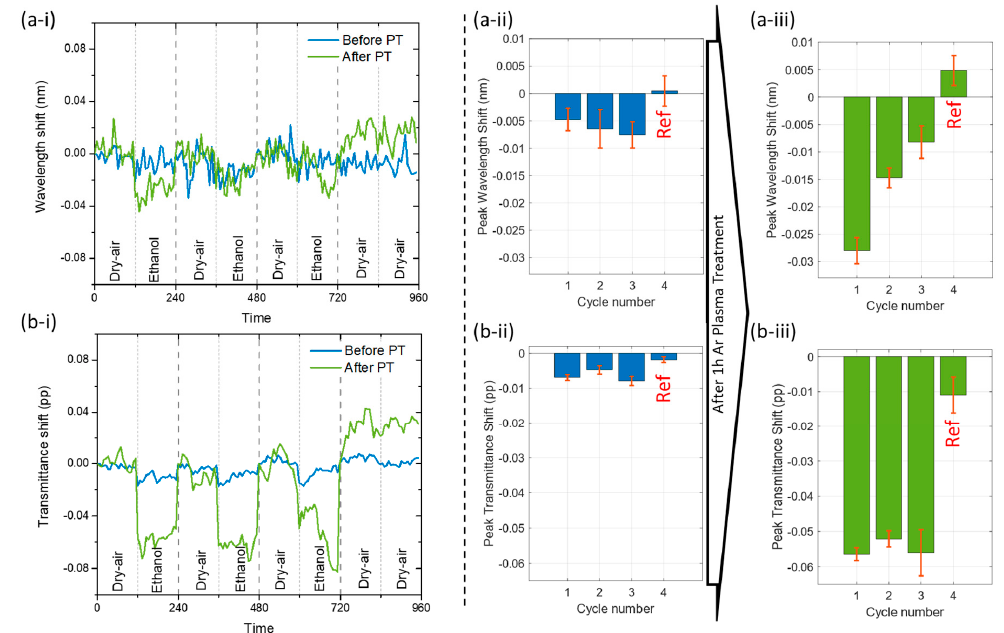
Figure 4. LSPR peak position monitoring of dry-air and ethanol vapor cycles, before (blue) and after (green) 1h Ar plasma treatment show ( a ) the wavelength and ( b ) the transmittance coordinates shift of the LSPR peak. ( a-i,b-i ) Over-time measurements. Before plasma treatment, an average wavelength blueshift of only ( a-ii ) 0.006 nm gave rise to ( a-iii ) a three-fold increase corresponding to 0.017 nm, while the transmittance shift was increased from ( b-ii ) 0.007 pp to ( b-iii ) 0.055 pp (nine-fold increase).